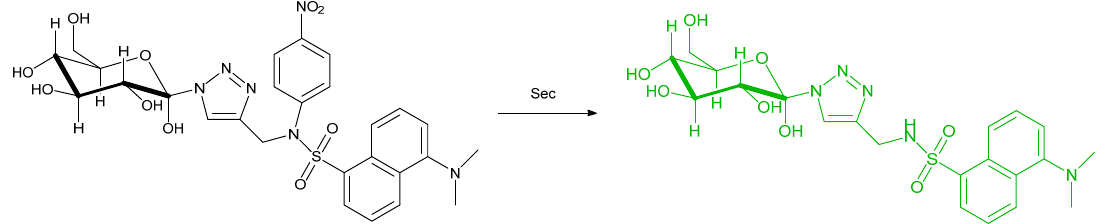
Figure 48. Structure and intended reactivity for chemosensing probe NO2 L studied for selenocysteine detection by Areti et al.